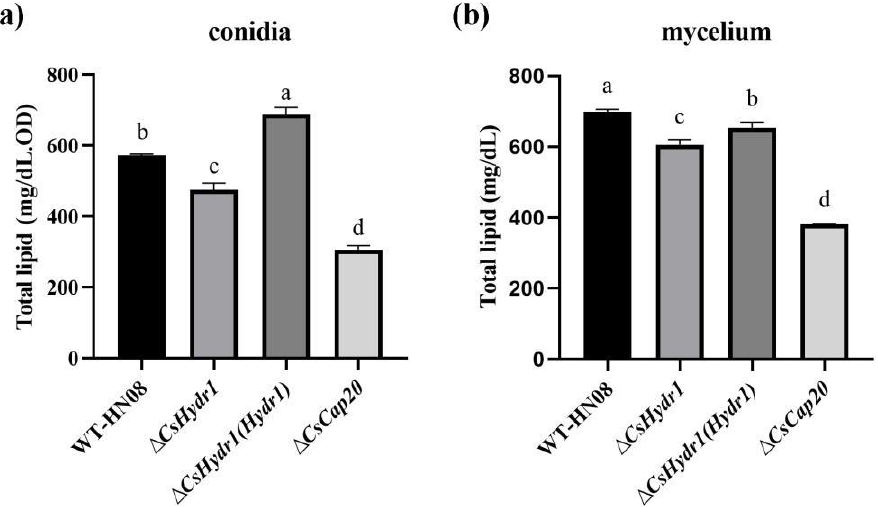
Figure 8. Lipid content relationship of CsHydr1 and CsCap20. Quantification of lipids from conidia ( a ) and mycelia ( b ) in HN08, the ∆ csHydr1 mutant, the ∆ csHydr1 ( Hydr1 ) strain and the ∆ csCap20 mutant. Different letters (a, b, c, d) represent significant